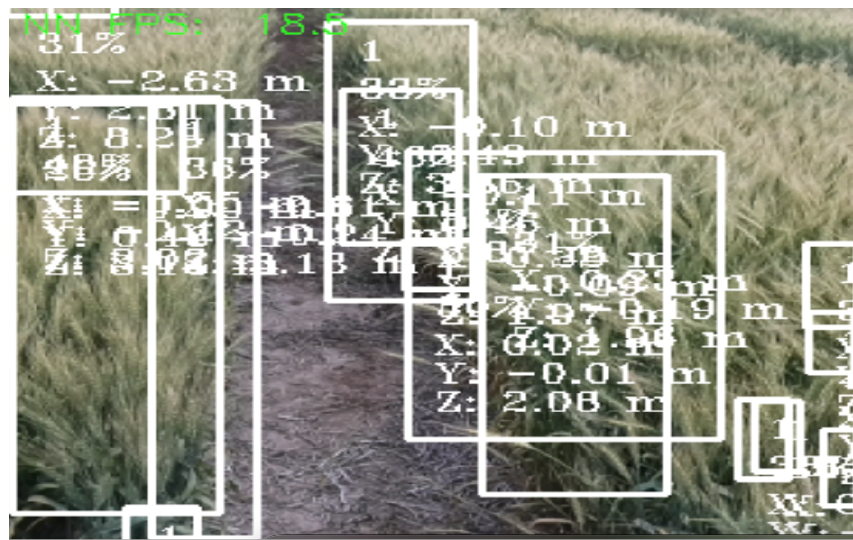
Figure 14. Real-time depth sensing of wheat in the